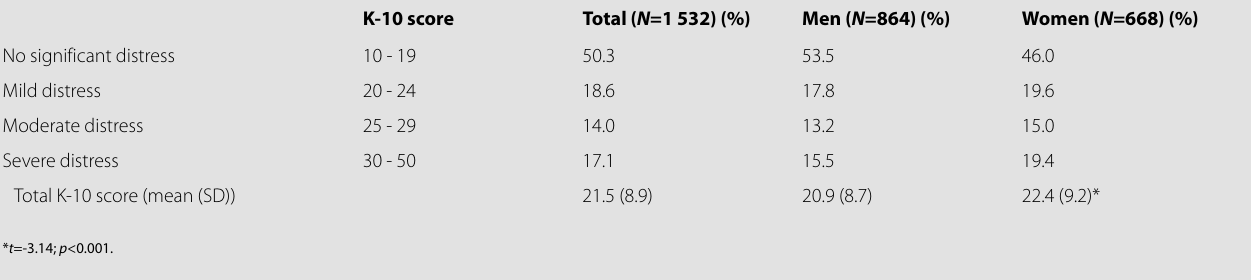
Table 2. Levels of psychological distress of male and female participants